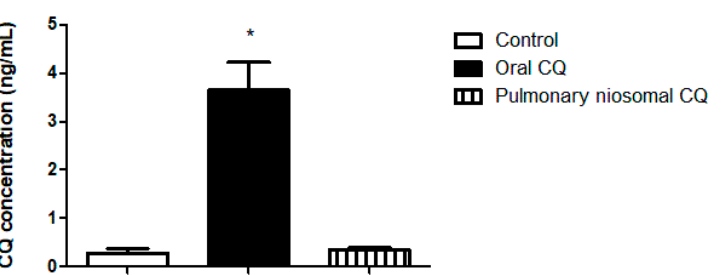
Figure 6. Chloroquine (CQ) concentrations in the blood of the treated animals following oral and intratracheal administration of drug solution and drug-loaded niosomes, respectively. Values are illustrated as means ± SDs ( n = 5). The * denotes statistical significance from the control group ( p < 0.0001) using a one-way analysis of variance (ANOVA), followed by Tukey–Kramer as a post-hoc test.